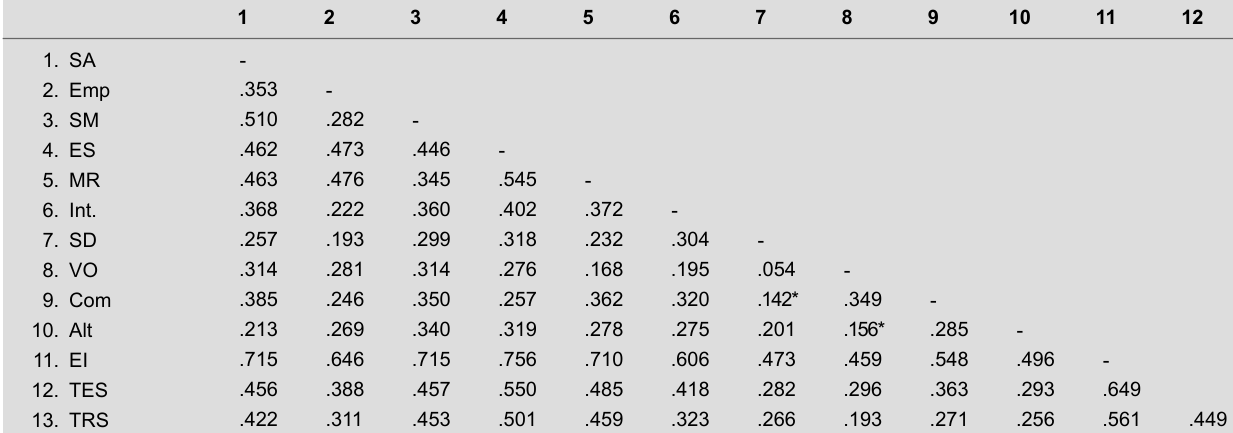
SDStd. Error of MeanMeanMaxMinN